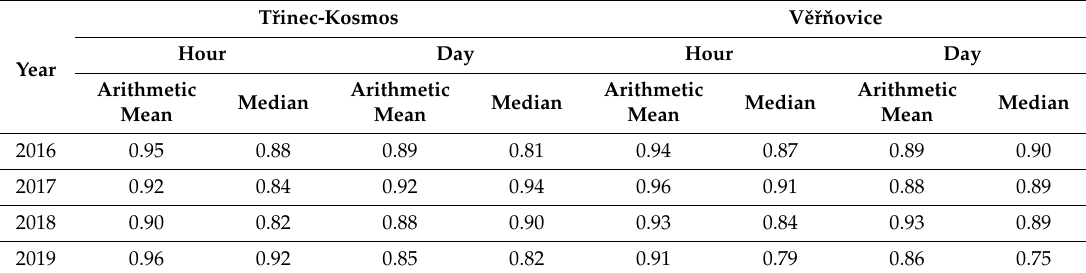
Table 3. Correlation coefficients of dependences of the temperature on the MLH at the T ř inec-Kosmos and V ěřň ovice sites, 2016–2019.